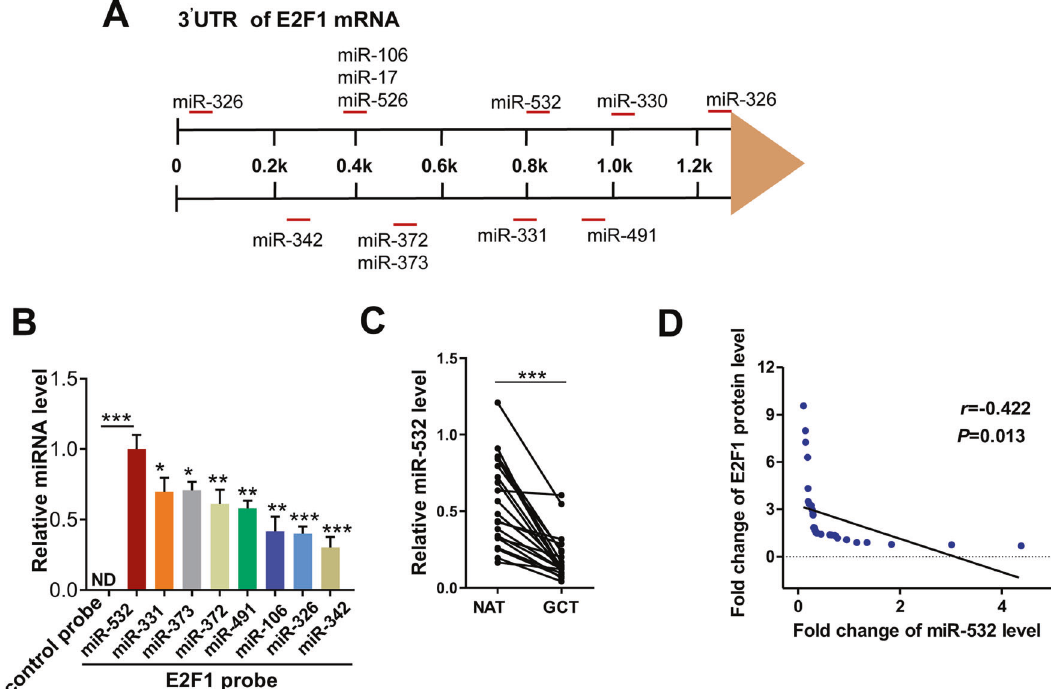
Fig. 3 Prediction of E2F1 as a target of miR-532. A Schematic overview regarding 12 candidate miRNAs targeting E2F1 3 ′ -UTR. B QRT-PCR analysis of miRNA levels in MKN-45 after pulling down by E2F1 mRNA probe or control probe. C Representative expression of miR-532 in GC and NAT analyzed by QRT-PCR. D Pearson ’ s correlation scatter plot of the fold change of miR-532 and E2F1 in 21 pairs of GC tissues. * P < 0.05; ** P < 0.01; *** P <